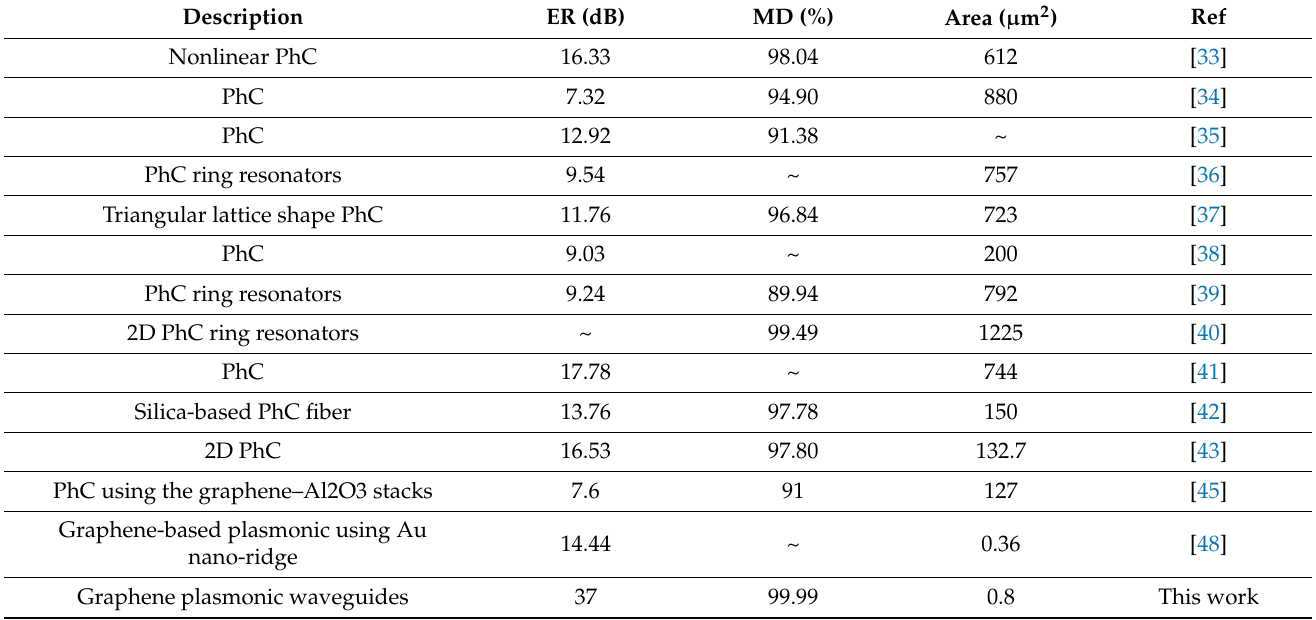
Table 5. Comparison of the obtained results with other